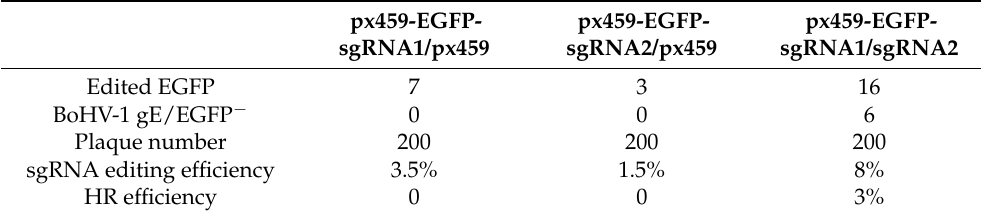
Table 3. The gene editing in BoHV-1 gE/EGFP − using px459-EGFP-sgRNA1/px459-EGFP-